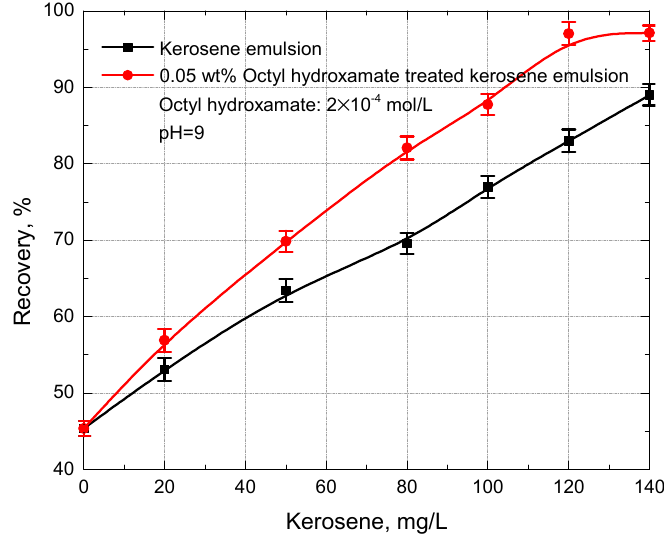
Figure 3. Flotation recovery of malachite with the addition of two kinds of kerosene emulsions as a function of kerosene dosage.